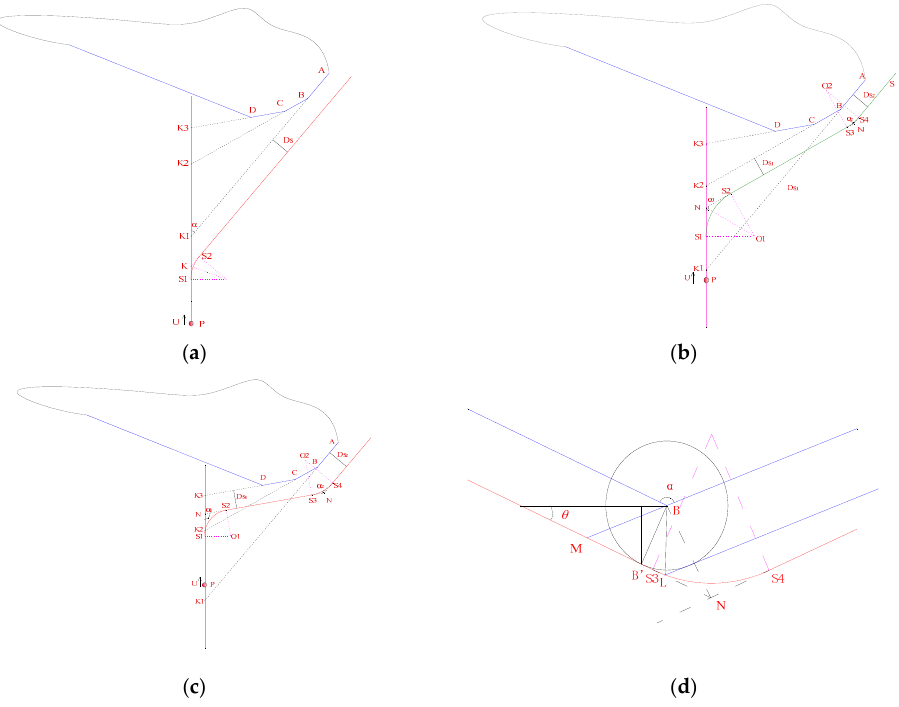
Figure 8. ( a – c ) Path design for single obstacle; ( d ) Local amplification diagram.